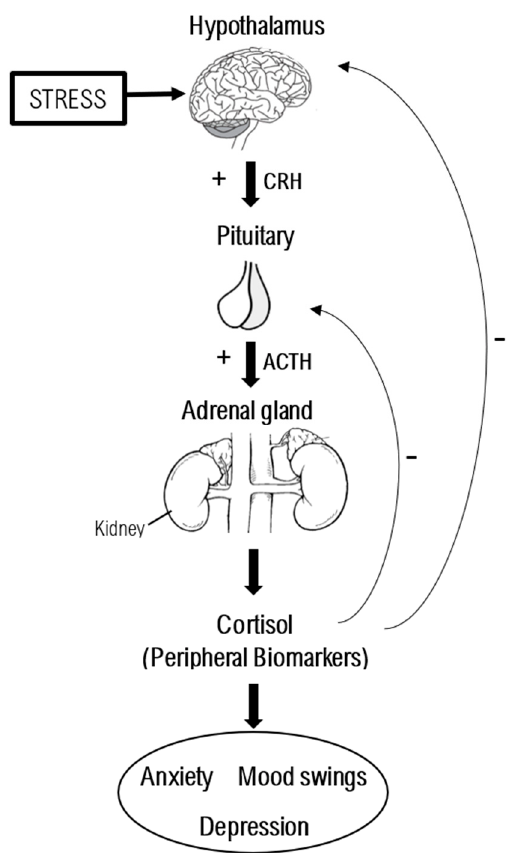
Figure 2. Illustration of the hypothalamic–pituitary–adrenal axis and related peripheral biomarkers. The hypothalamic–pituitary–adrenal (HPA) axis is an endocrine system based on feedback interactions among the hypothalamus, the anterior pituitary gland, and the adrenal glands. The neuroendocrine cells of the hypothalamus produce CRH (corticotropin-releasing hormone), which is then released into the adenohypophysis where it induces the synthesis of ACTH (adrenocorticotropic hormone). Finally, the adrenal cortex produces glucocorticoids (mainly cortisol) in response to ACTH stimulation. The stress-related dysregulation of the HPA axis in mood and anxiety disorders can be assessed by measuring the peripheral biomarkers, such as plasma, urinary, hair, and salivary cortisol, or the releasing factors (CRH and ACTH) and neurotransmitters (epinephrine and norepinephrine).